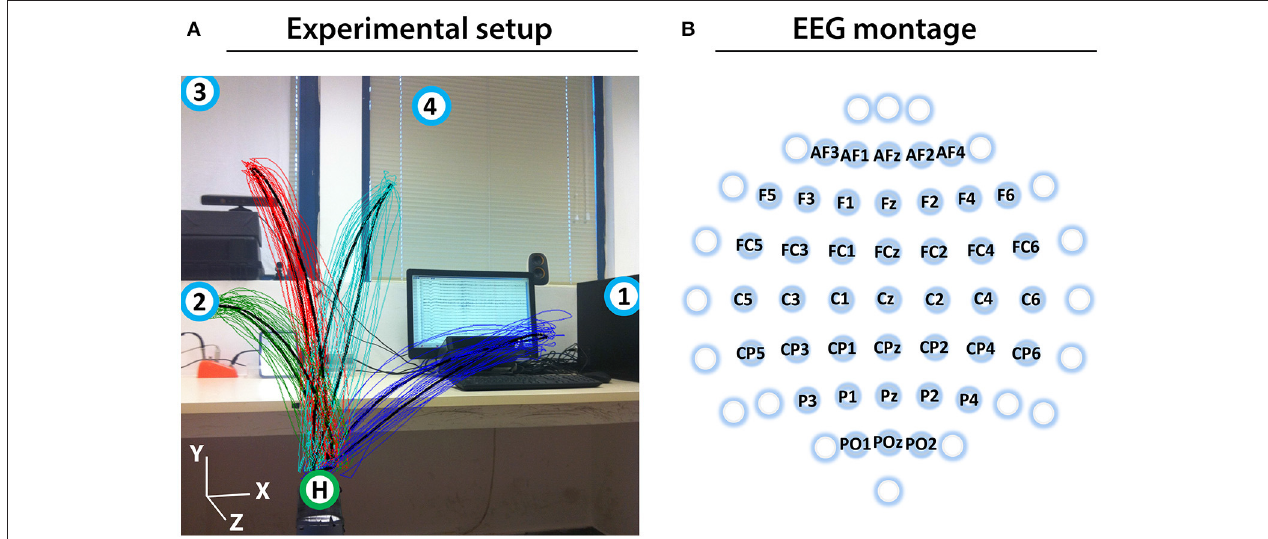
FIGURE 1 | Experimental setup and EEG montage. (A) Experimental setup including an overlaid image of the 3D trajectory of the registered (colored thin curves) and averaged (black thick curves) arm movements between the home position (green circle with H) and four target positions (blue circles with numbers) of a representative